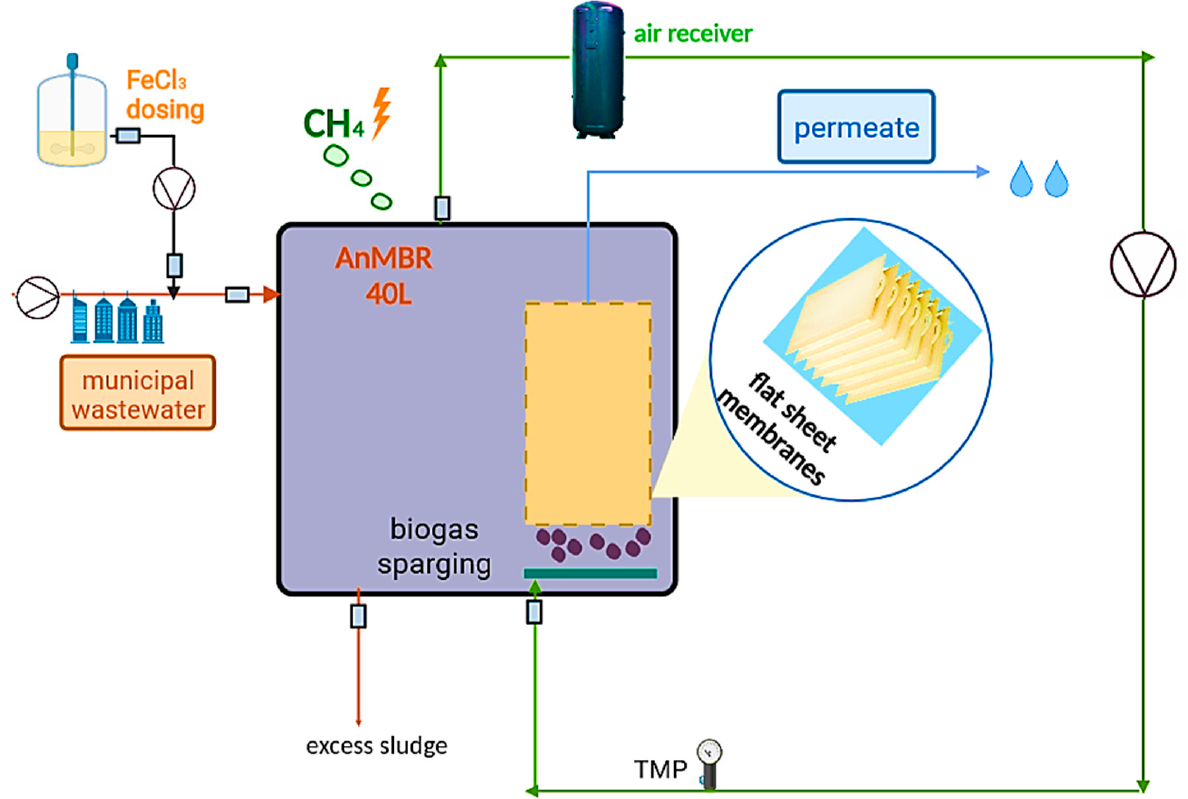
Figure 1. Flow schematic of the laboratory-scale AnMBR.